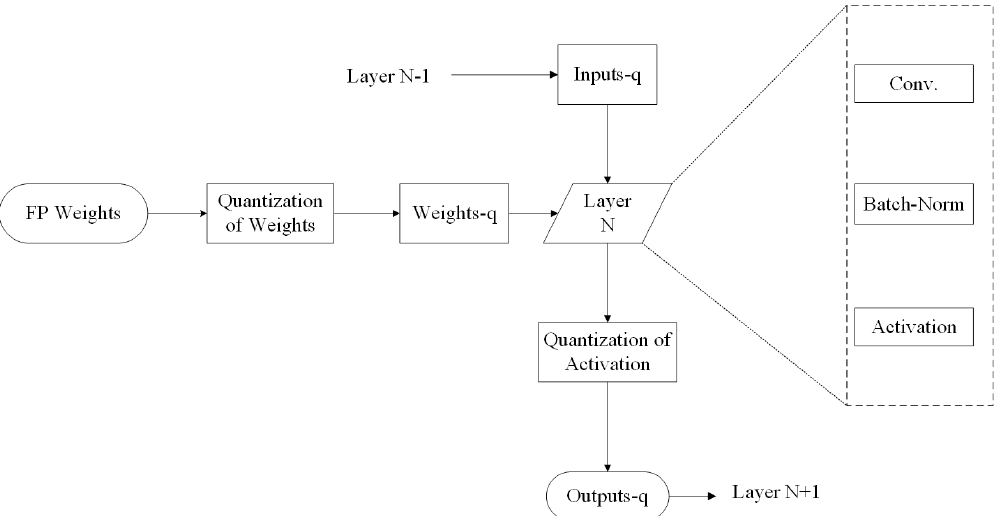
Figure 1. Schematic Diagram: Quantization Neural Network.